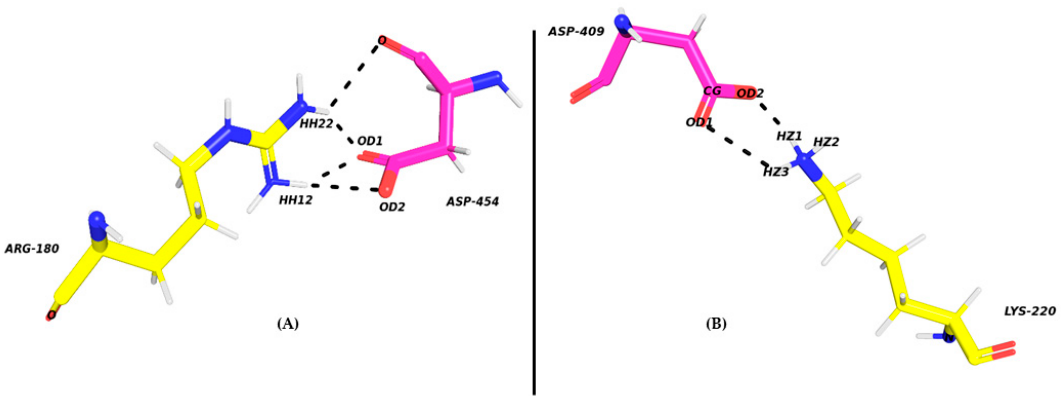
Figure 5. The main salt bridges formed between DARPins and ERK2. ( A ) ARG180-NH2–ASP454-OD1 and ( B ) LYS220 NZ2-ASP409 OD2. Salt bridges are shown by black dots.